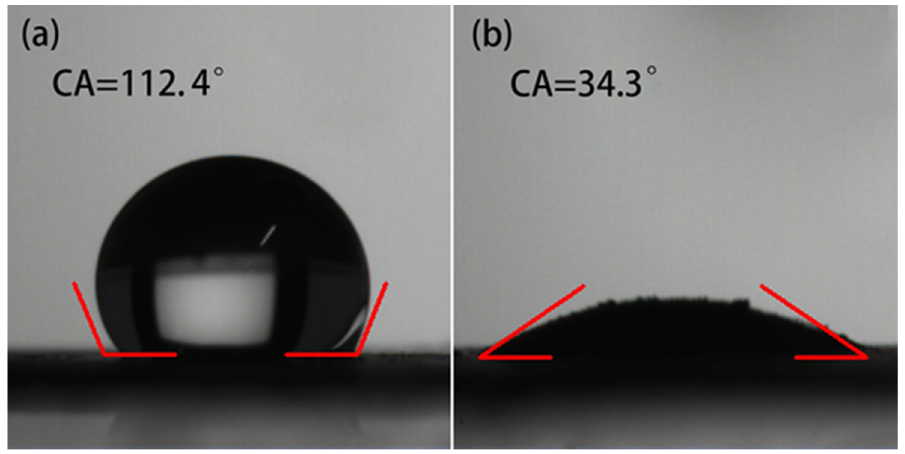
Figure 6. Surface wettability of ( a ) 1T-MoS 2 and ( b ) 1T-MoS 2 /PC. Additionally, the BET surface areas of the 1T-MoS 2 , 1T-MoS 2 /PC and pelagic clay were measured and were found to be 4.4, 27.0 and 100.4 m 2 g − 1 , respectively. Based on the analysis of these data, following its hybridization with pelagic clay, 1T-MoS 2 /PC exhibited